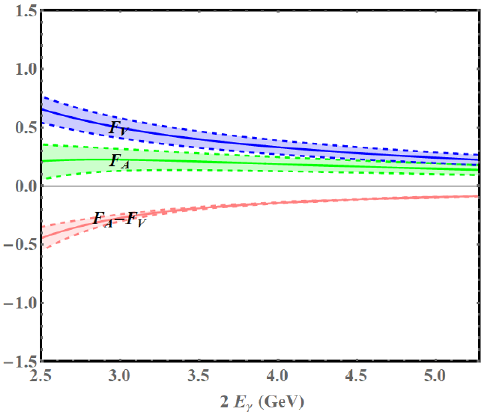
Figure 8 . The photon-energy dependence of the B ! (cid:13)‘(cid:23) form factors as well as their di(cid:11)erence computed from (4.15) with the theory uncertainties from variations of di(cid:11)erent input parameters added in